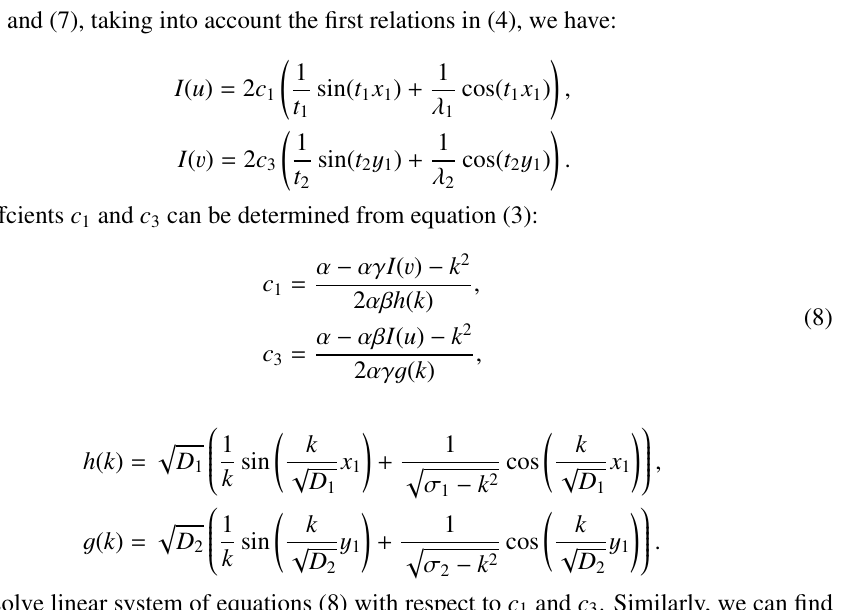
= 0 . 6478 , c = 11 . 0920 , c 1 2